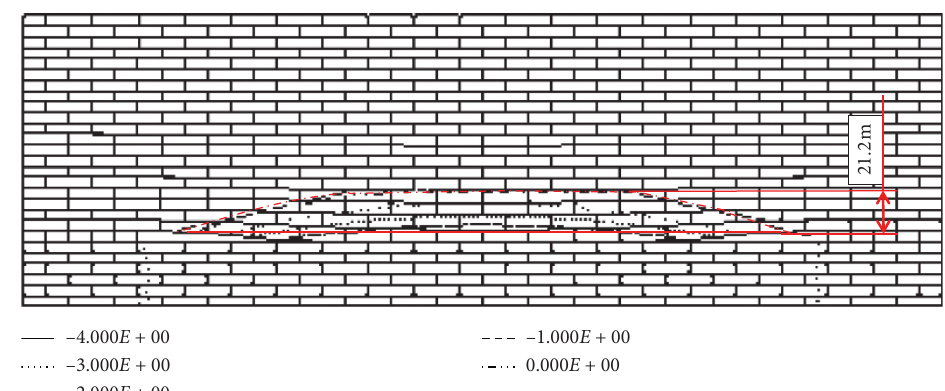
Figure 8: Caving and displacement evolution trend of overlying strata in the lower group coal mining.